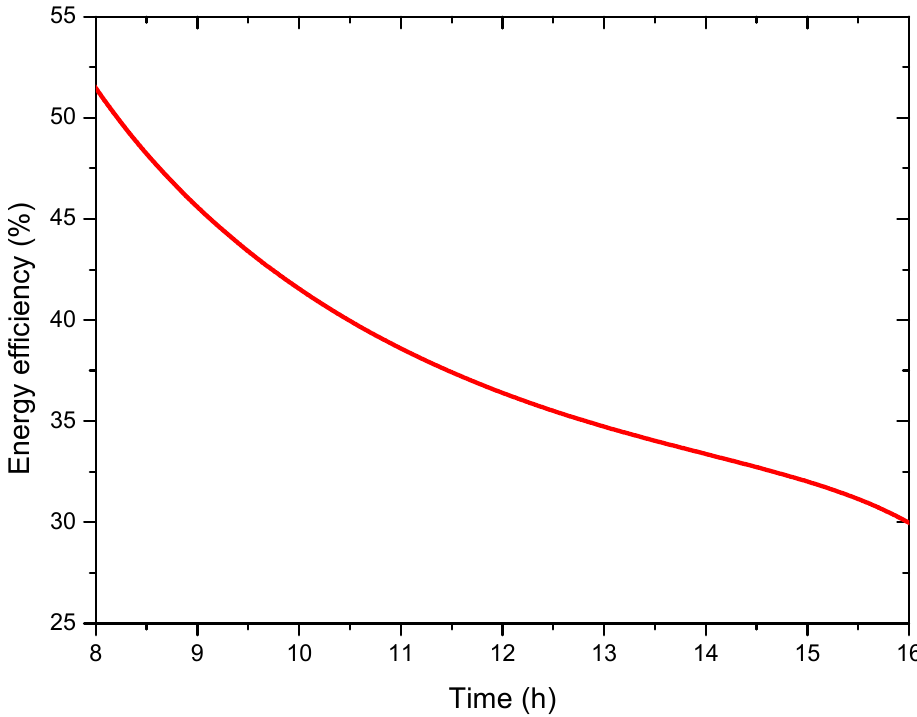
Figure 11. Variation of the collector energy efficiency variation with a solar with time.